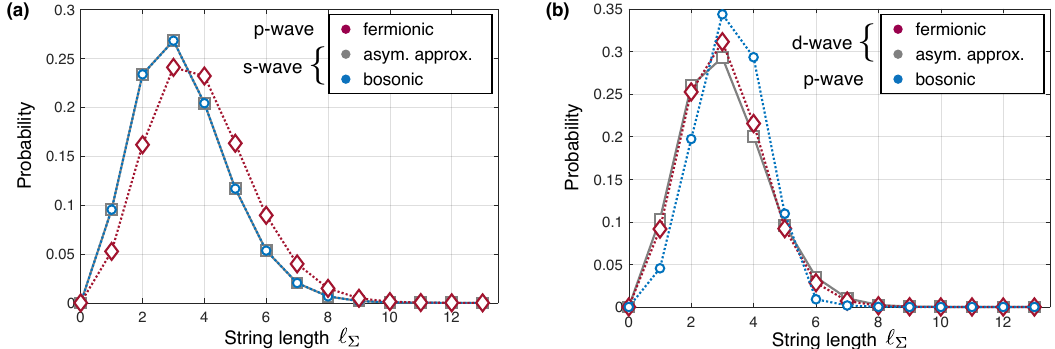
Figure 7: String-length distributions for fermionic (red) and bosonic (blue) holes in (a) the ground state around k = 0 and (b) in the lowest-energy state around k = ( π , π ) . Predictions by the asymmetric approximation are also shown (gray).